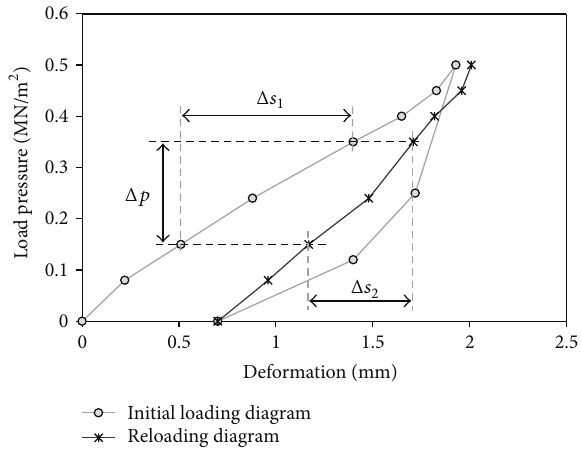
Figure 1: Example load-deformation curves for